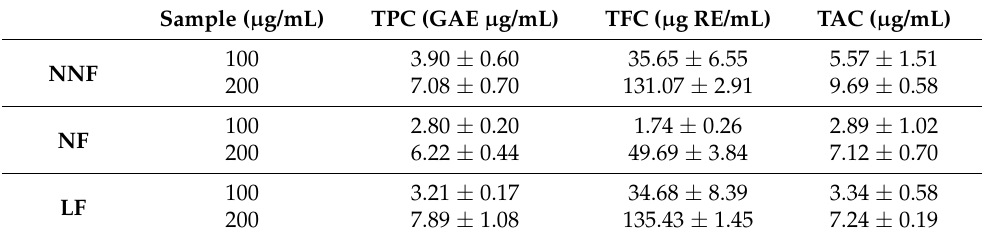
Table 3. Contents of total phenolic, flavonoid, and anthocyanin compounds. Data are expressed as means ± SD ( n =